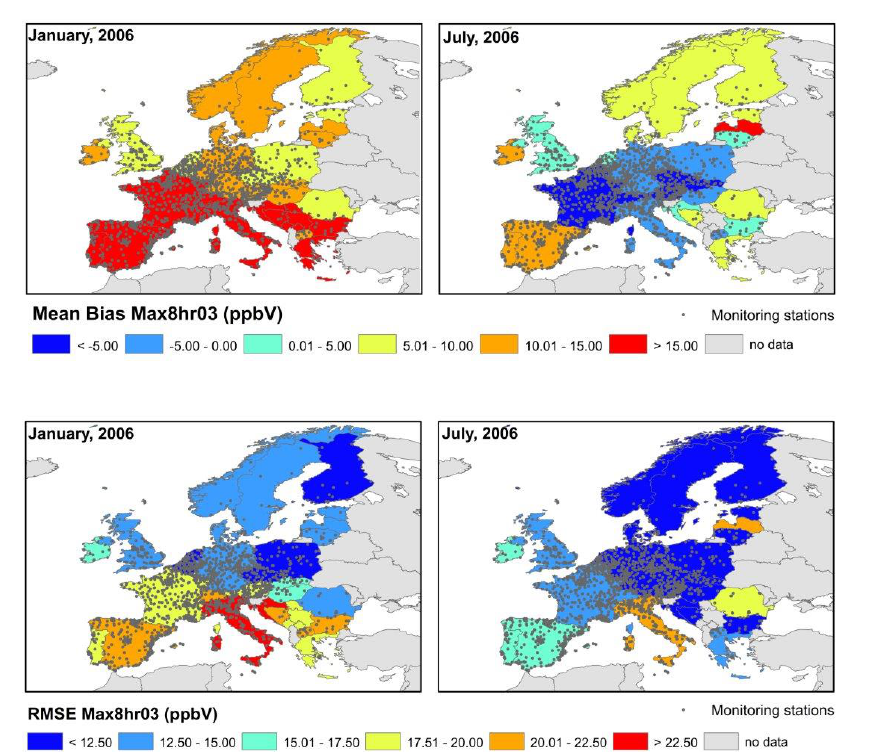
Fig. 4. Mean Bias and RMSE for daily average Max8hO 3 mixing ratios for the European countries (dots show the distribution of O 3 monitoring